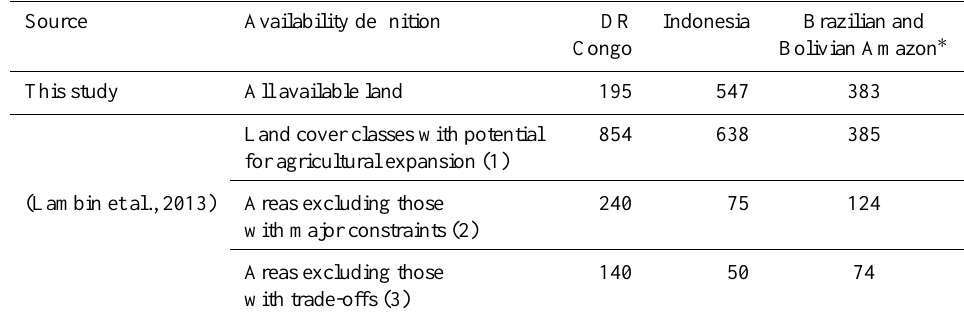
Table 6. Available land area (in ‘000km 2 ) for three regions.